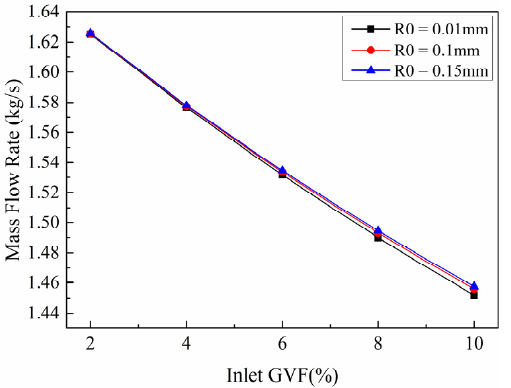
Figure 11. Seal leakage (mass flow rate) of the model seal versus inlet GVF under different bubble radii for Δ P = 48.3 bars.